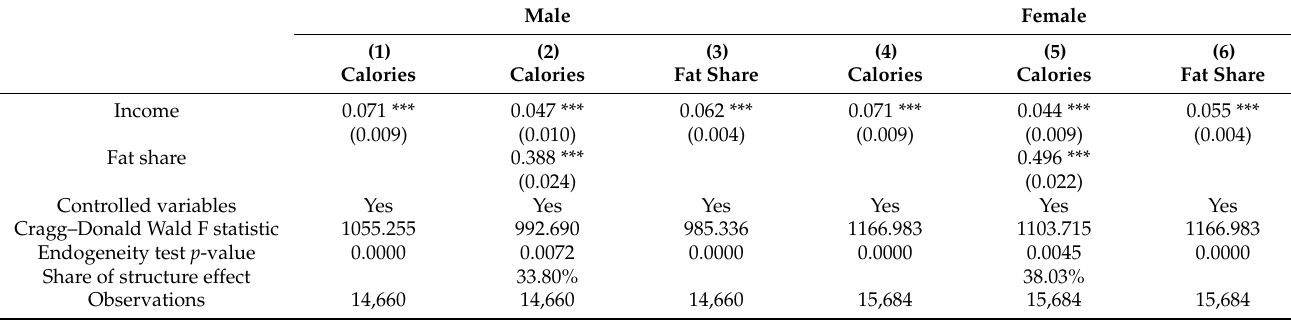
Table 4. Gender gap in the effect of income on calorie consumption.